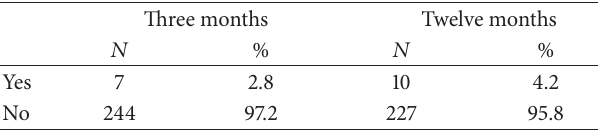
Table 10: “Decided to modify the prescribed dose in the last 4 weeks?” Three